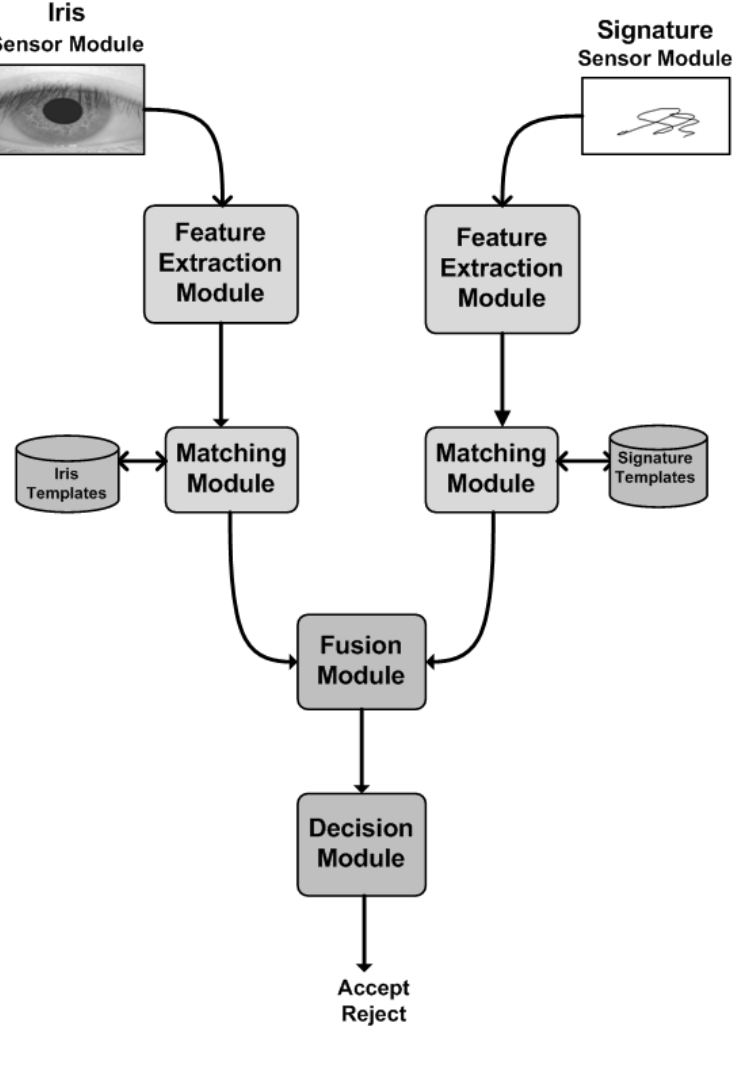
Figure 1. Multi-modal Biometrics System (Iris &